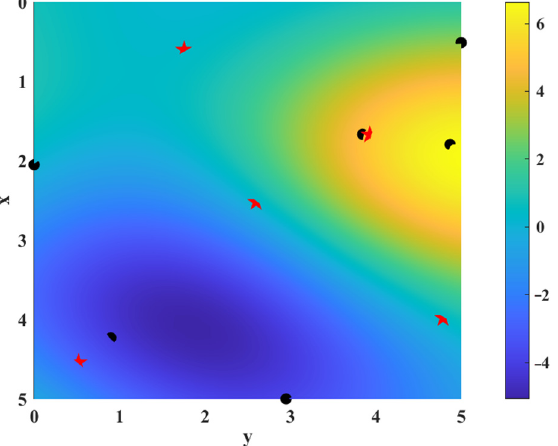
Figure 8. Shape and characteristics of the two-dimensional functions.